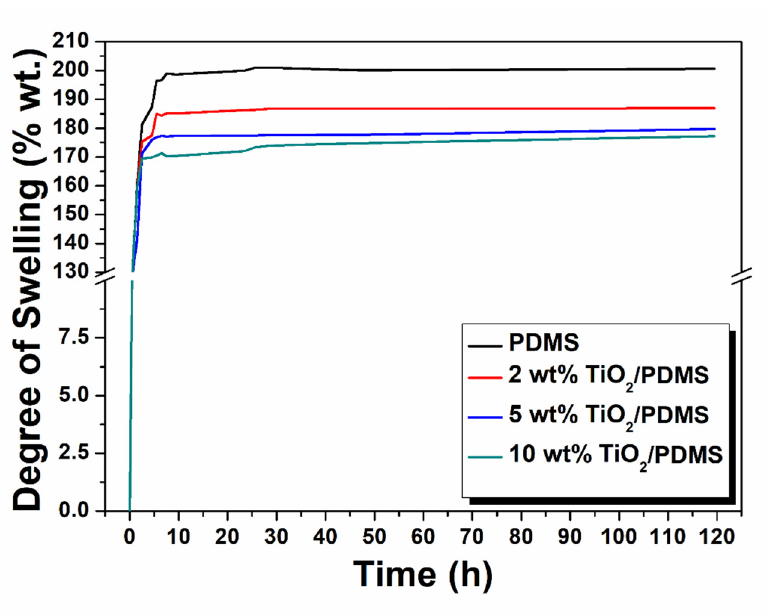
Figure 4. Swelling experiment in toluene of PDMS and TiO 2 /PDMS nanocomposites. Table 4. M c (g/mol) results of TiO 2 /PDMS nanocomposites based on swelling (Flory-Rehner ap- proach).